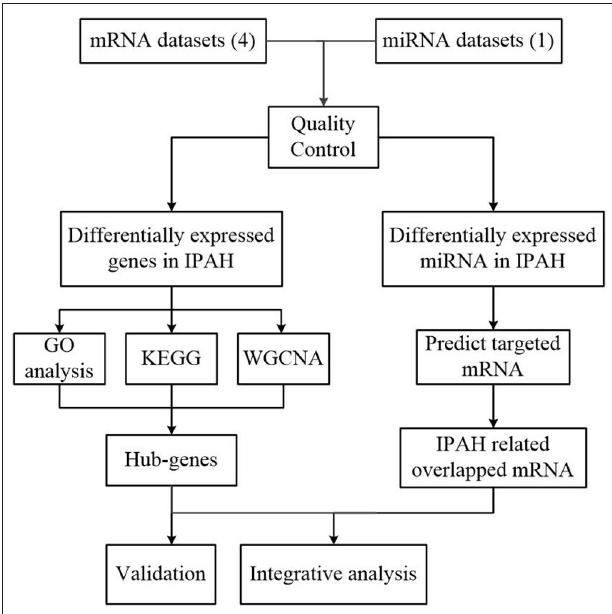
FIGURE 1 | Flowchart of the bioinformatics analysis. MiRNA, microRNA; RRA, robust rank aggregation; IPAH, idiopathic pulmonary arterial hypertension; GO, Gene Ontology; KEGG, Kyoto Encyclopedia of Genes and Genomes; WGCNA, the weighted gene coexpression network analysis.